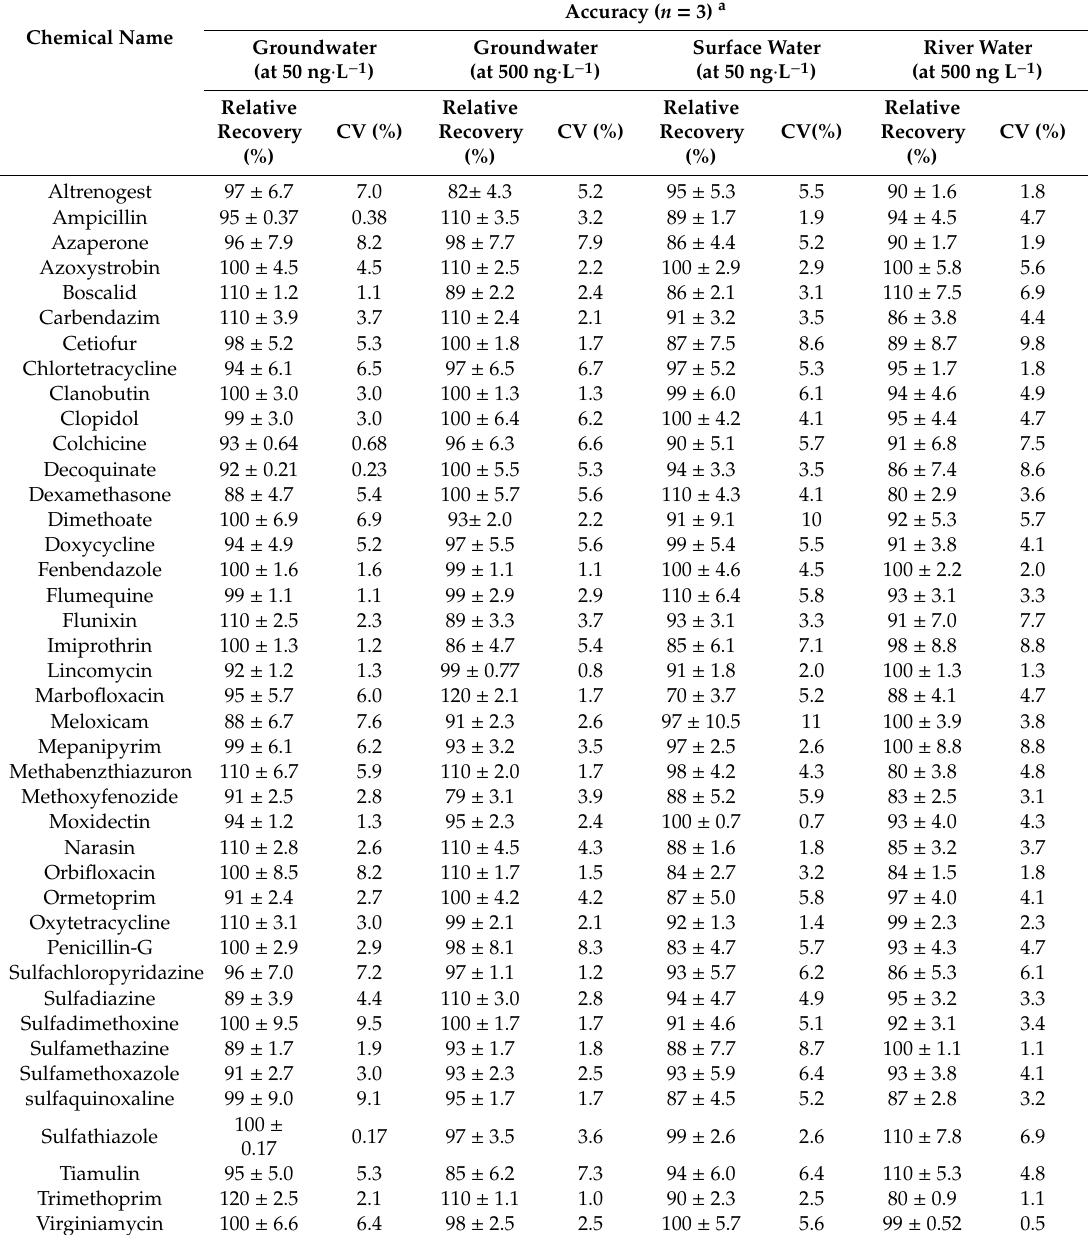
Table 6. Accuracy including relative recovery and coe ffi cient of variation (CV) data of the developed method with on-line SPE for target